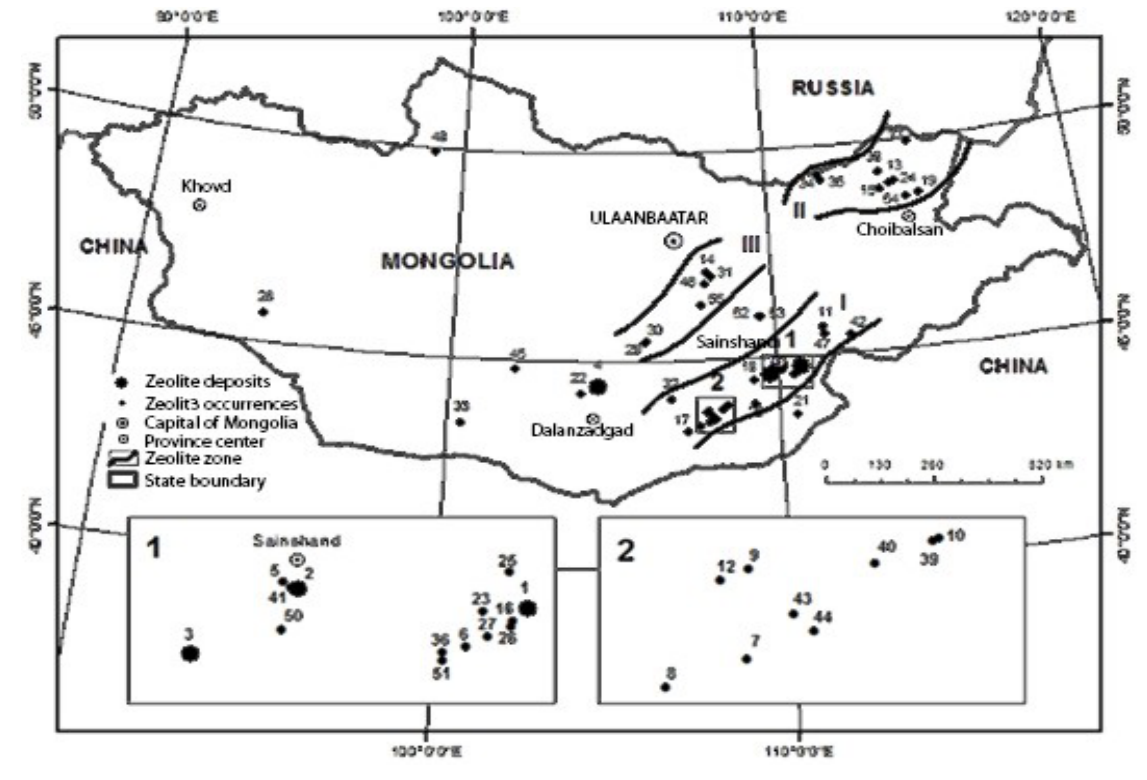
Fig. 1. Distribution of zeolite deposits in